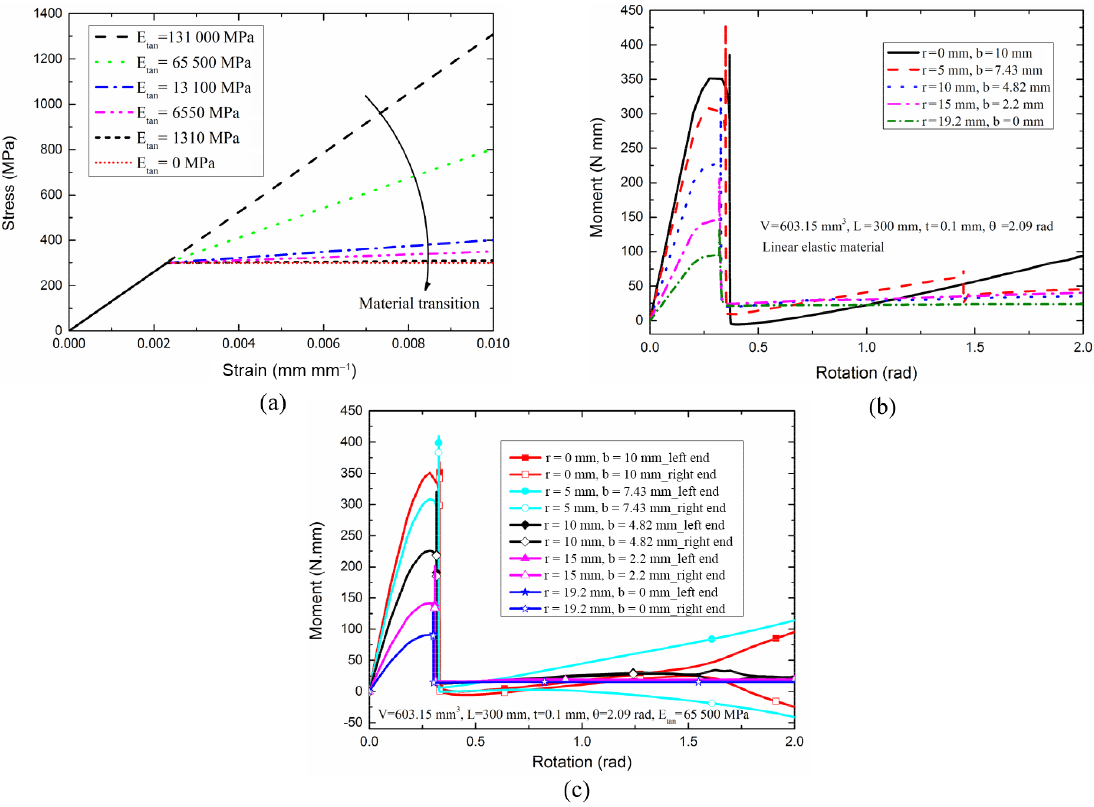
Figure 10. (a) Ideal true stress-strain curves of different materials with changing tangent moduli, (b) moment-rotation curves obtained from finite element modelling by using linear elastic material model, and (c) by using bilinear material model with the tangent modulus E tan =